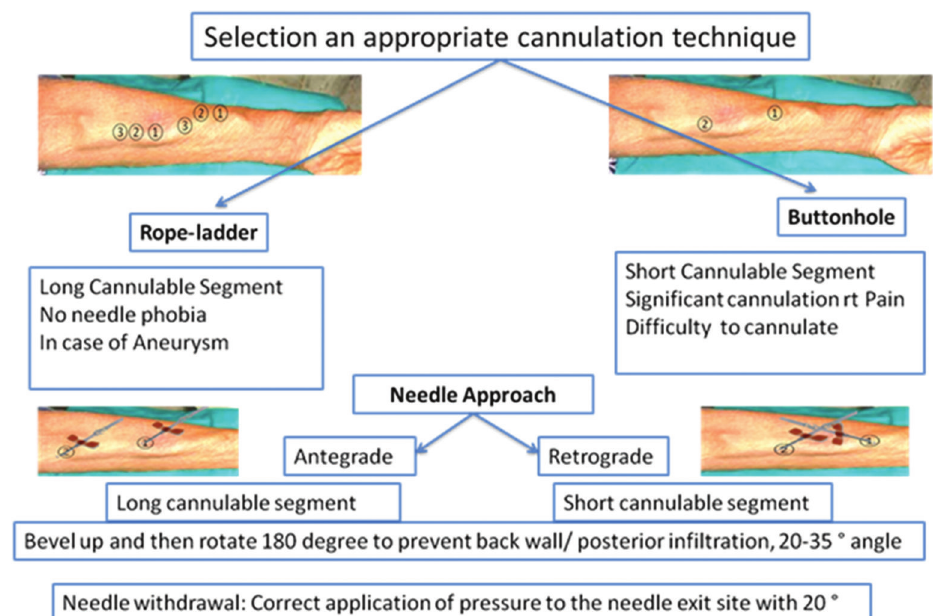
FIGURE 1. Selection an appropriate cannulation technique.